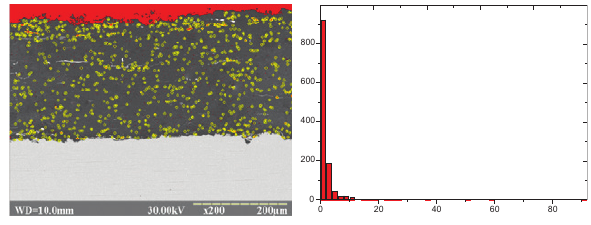
Figure 4. General view of the coating on the samples (cross section) grain-thickness F240